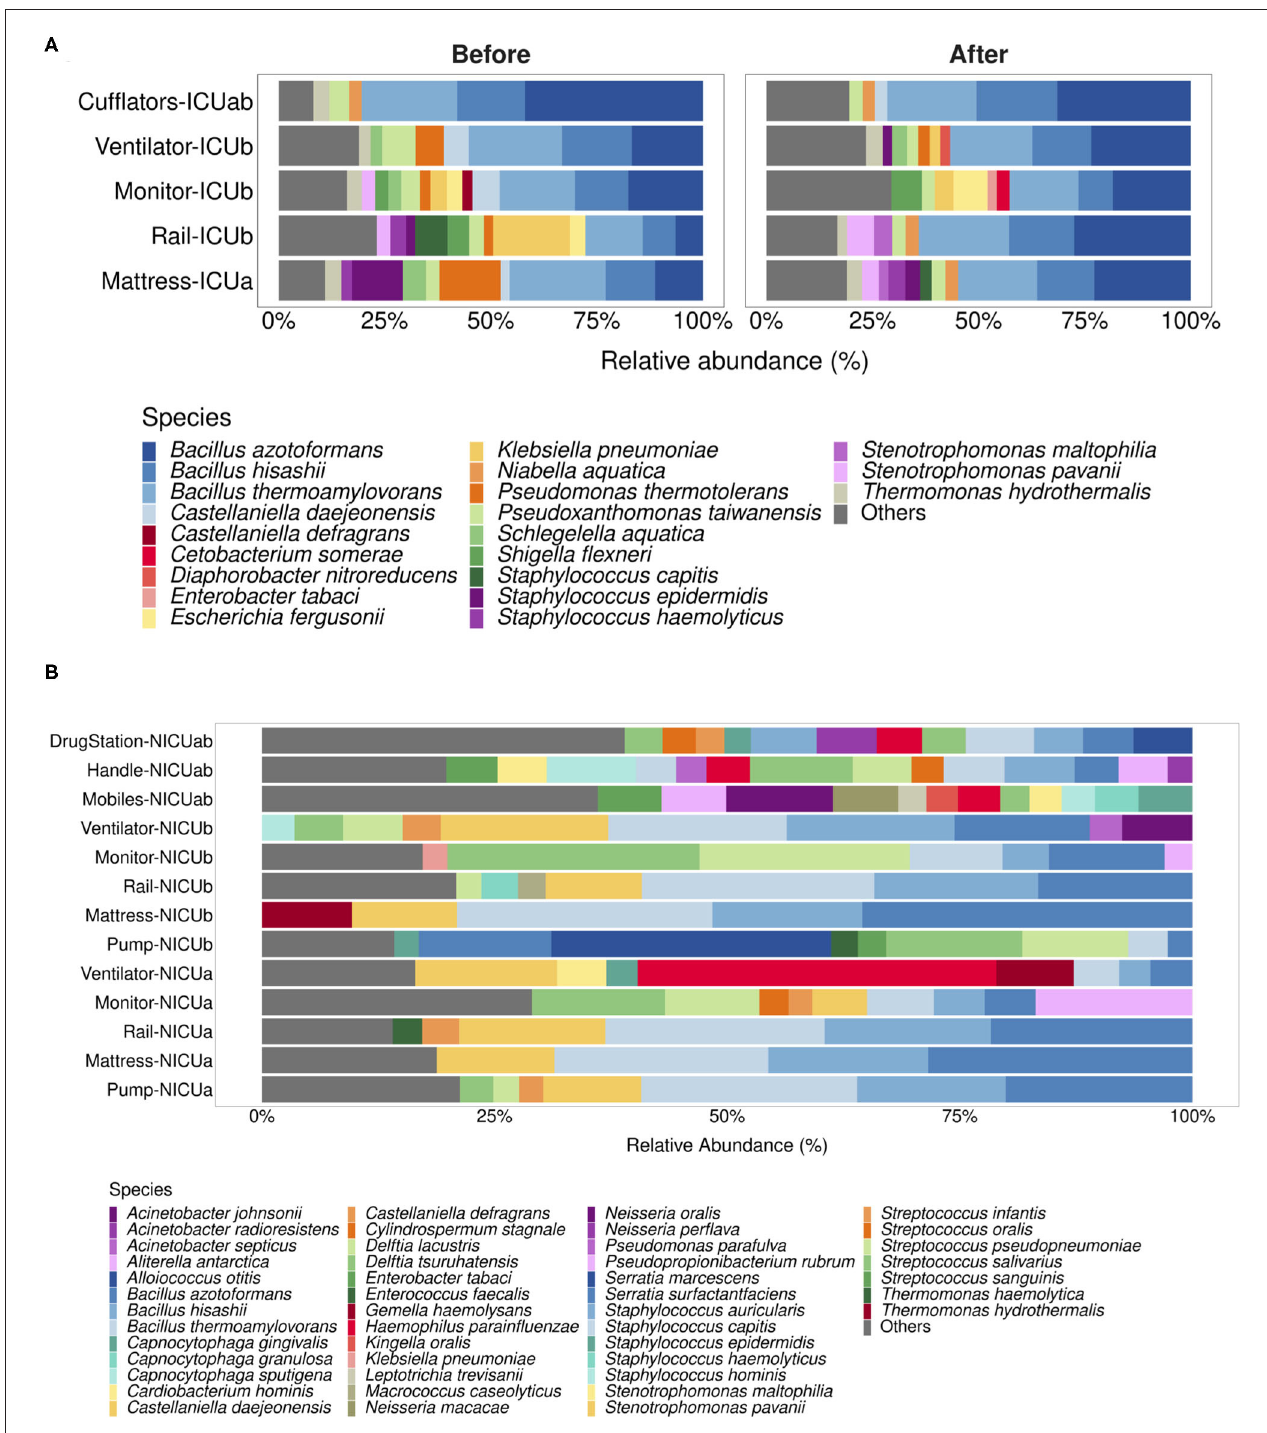
FIGURE 3 | Species-level taxonomic assignment to (N)ICU samples. (A,B) depict the main species assigned to nanopore-generated reads for ICU and NICU samples, respectively. Species with relative abundances below 2% for ICU samples or 2.5% for NICU samples were grouped into the label “Others.”